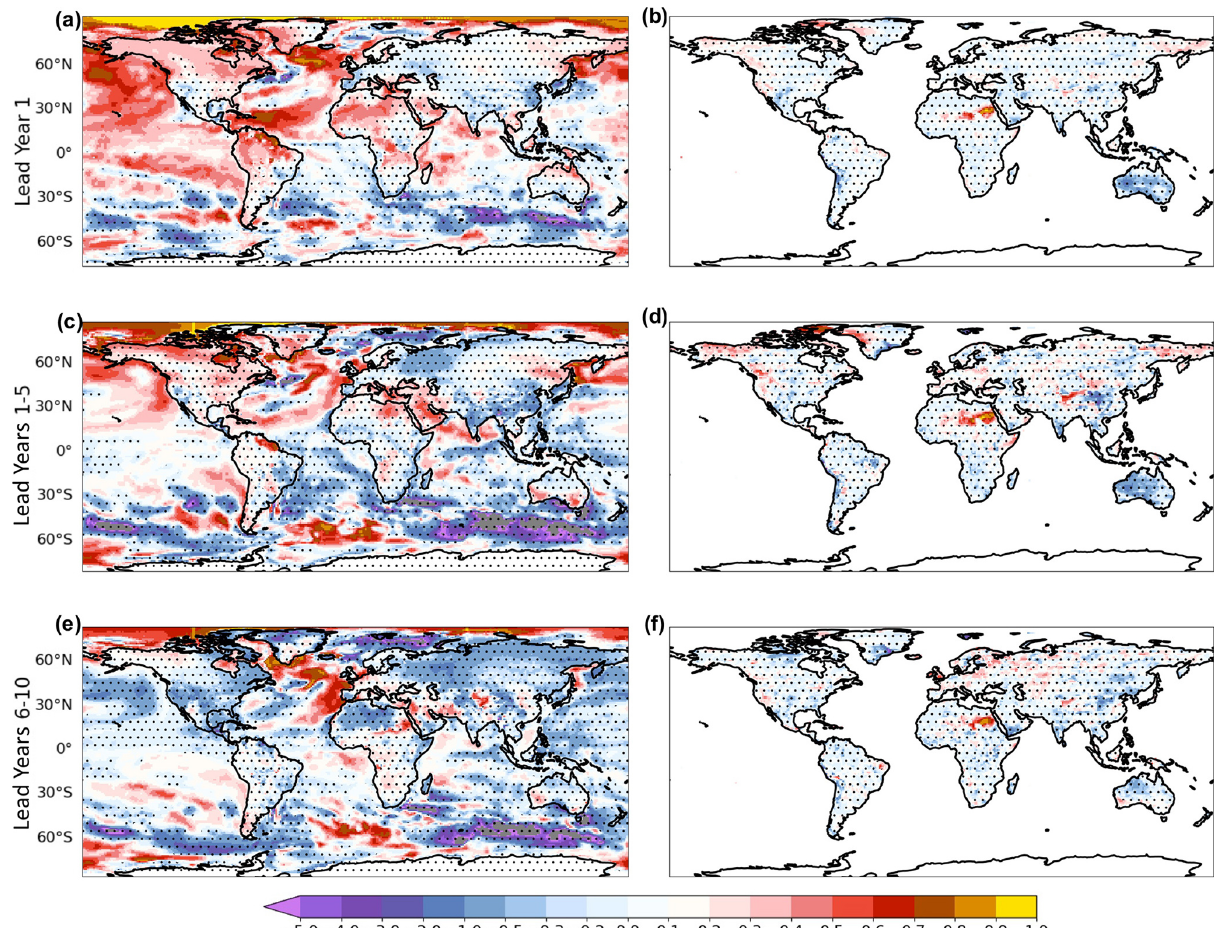
Figure 3. Near-surface temperature (T2m plus SST; a, c, e ) and precipitation (b, d, f) mean squared skill score (MSSS) of the hindcasts, using NoInit runs as the reference forecast to beat. Note that the color bar is not symmetric around zero. Stippling is used to indicate points where 95% statistical significance is not reached, according to a one-tailed t test. Effective degrees of freedom have been computed following Eq. (30) in Bretherton et al.